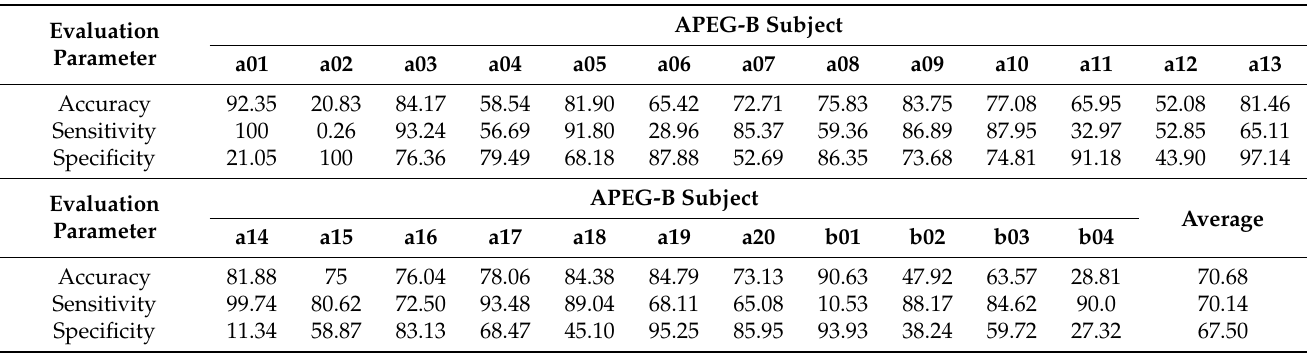
Table 9. Leave-one-subject-out cross-validation classification performance using a PAED-APEG-B